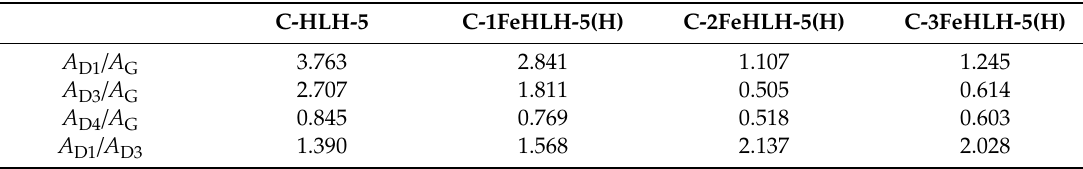
Figure 3. Raman spectra of carbonized chars with different amounts of FeCl 3 additive. Table 3. Parameters of hybrid carbon structure of carbonized chars with different amounts of FeCl 3 additive.